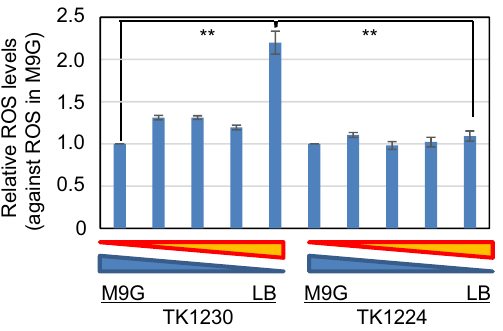
Figure 4. Effect of culture medium on ROS levels in ΔrecA306 polA25 cells. Fully grown TK1230 or TK1224 cells were inoculated in various media at 2 × 10 7 particles/mL (approximately 0.01 OD 600 ) and cultured for 24 h at 30 °C. ROS levels were analysed as in the “Methods”. From left to right, M9GCAA, 25% L medium with M9GCAA, 50% L medium with M9GCAA, 75% L medium with M9GCAA, and L medium. The results are shown as the mean ± SEM (n ≥ 3). Double asterisks indicate significant differences ( p < 0.01) as analysed using Welch’s t tests (n = 14).